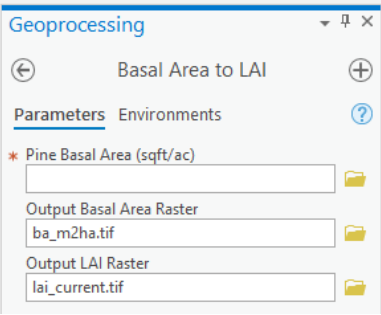
Figure A4. The geoprocessing window when using the Basal Area to LAI tool.